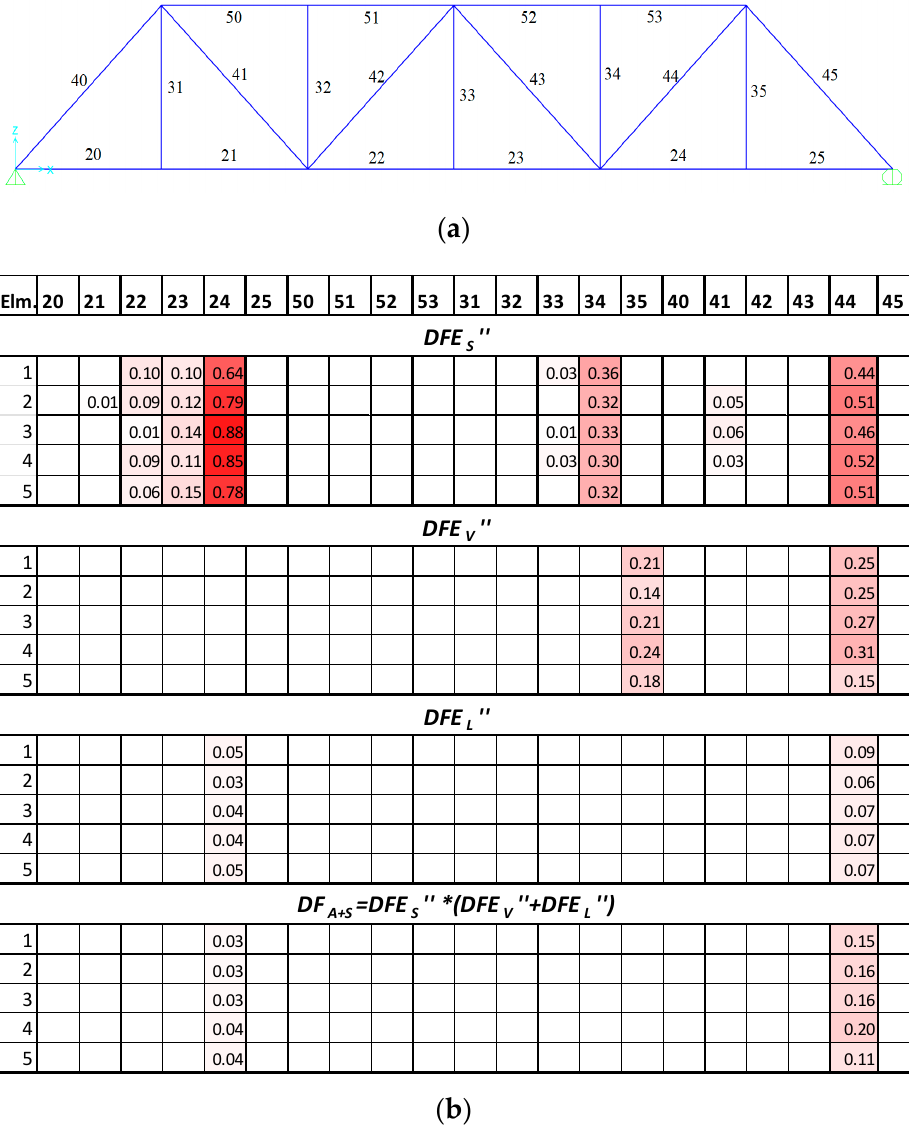
Figure 13. ( a ) The actual location of damage for damage case-5, ( b ) Identified damage using the proposed framework for damage case-5.